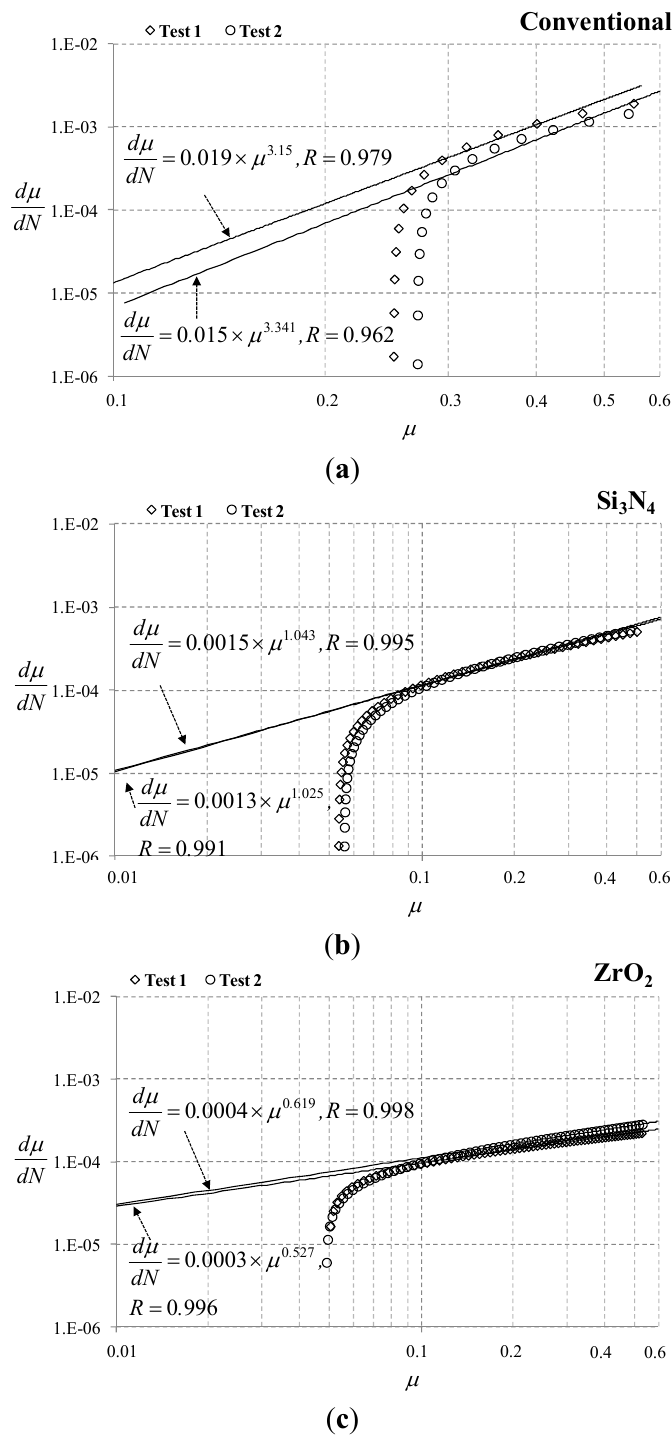
Figure 6. Determination of the parameters C and n on the log-log scale. “Conventional” denotes AISI 52100. ( a ) Conventional (AISI 52100); ( b ) Si 3 N 4 ; and ( c ) ZrO 2